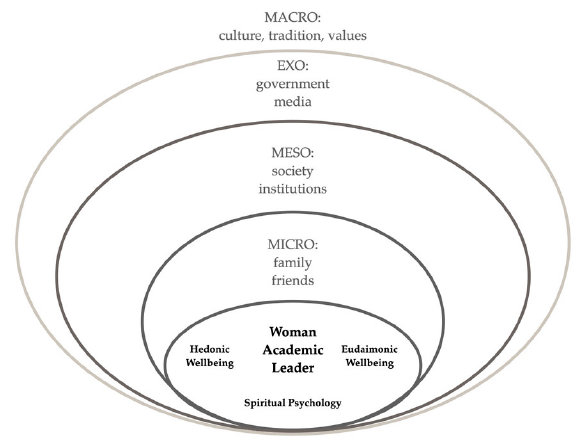
Figure 1. Conceptual framework.